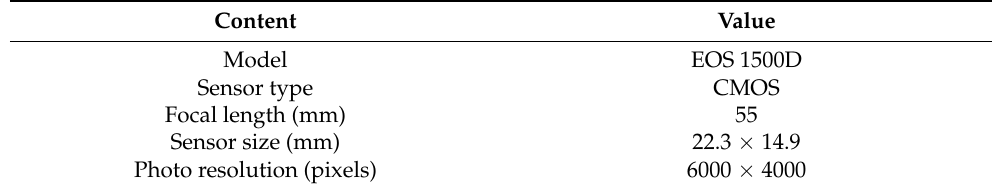
Table 1. The parameters of the